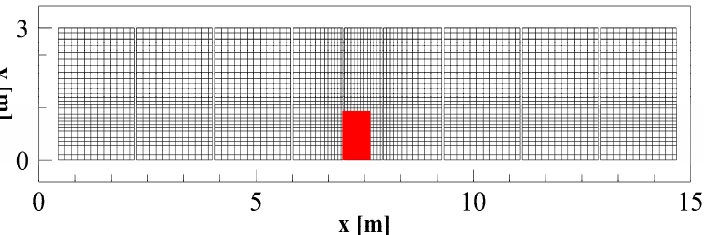
Figure 14. Wave–structure interaction. Plan view of the computational grid with the vertical emerged barrier (in red).